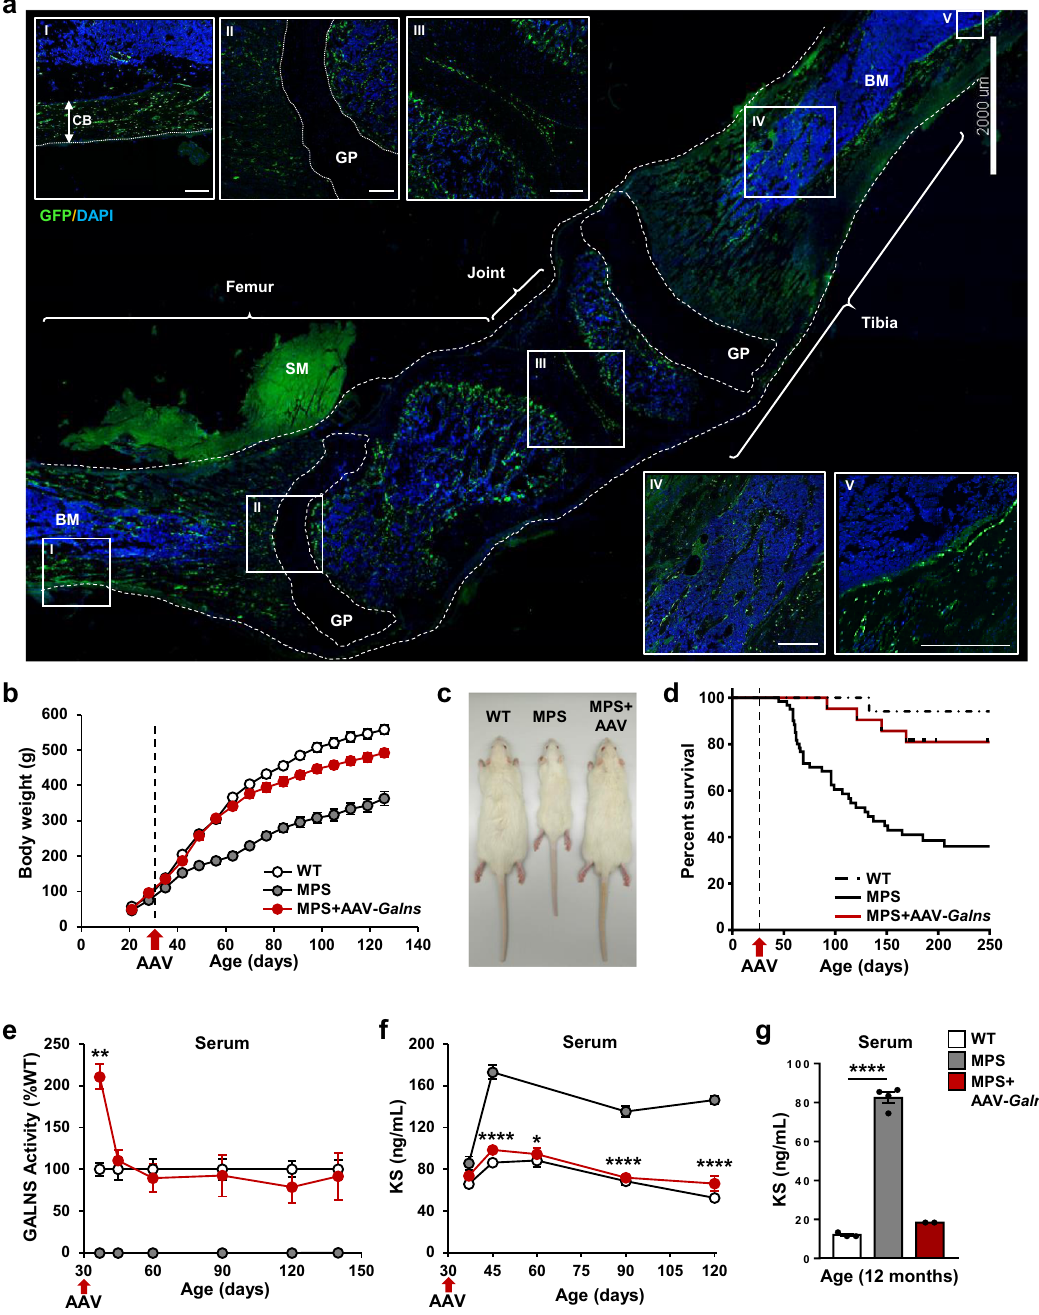
Fig. 1 AAV9- Galns treatment corrects MPSIVA pathology. a Widespread transduction of femur and tibia after intravascular administration of 6.67×10 13 vg/kg AAV9- GFP vectors to 4-weeks-old wild-type (WT) rats. Two weeks later, GFP signal was detected in compact bone (CB) (I), areas surrounding growth plate